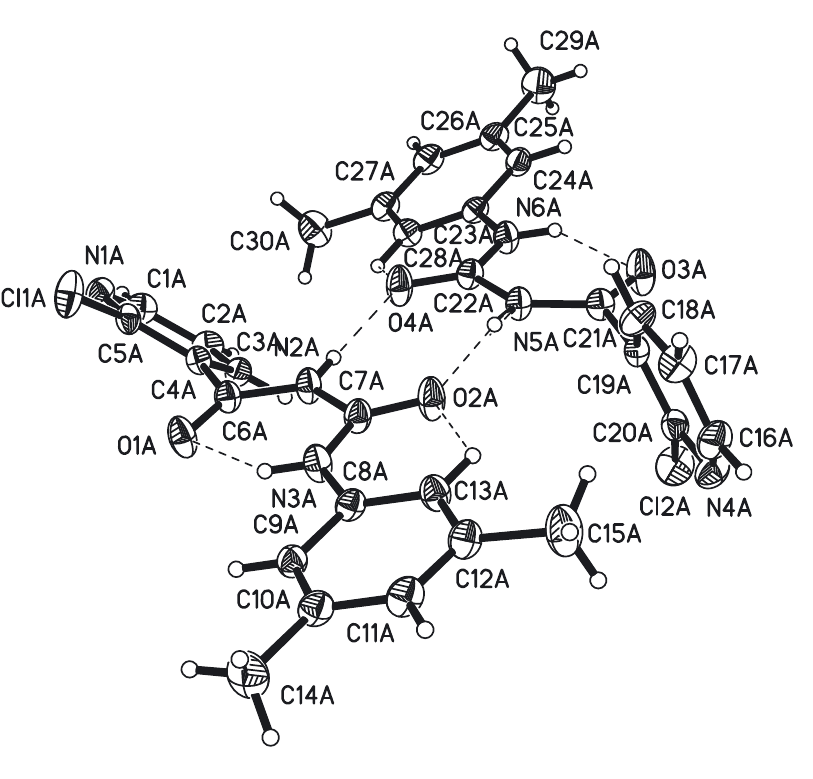
Table 1 contains crystallographic data and Table 2 contains the list of the atoms including atomic coordinates and displacement parameters.